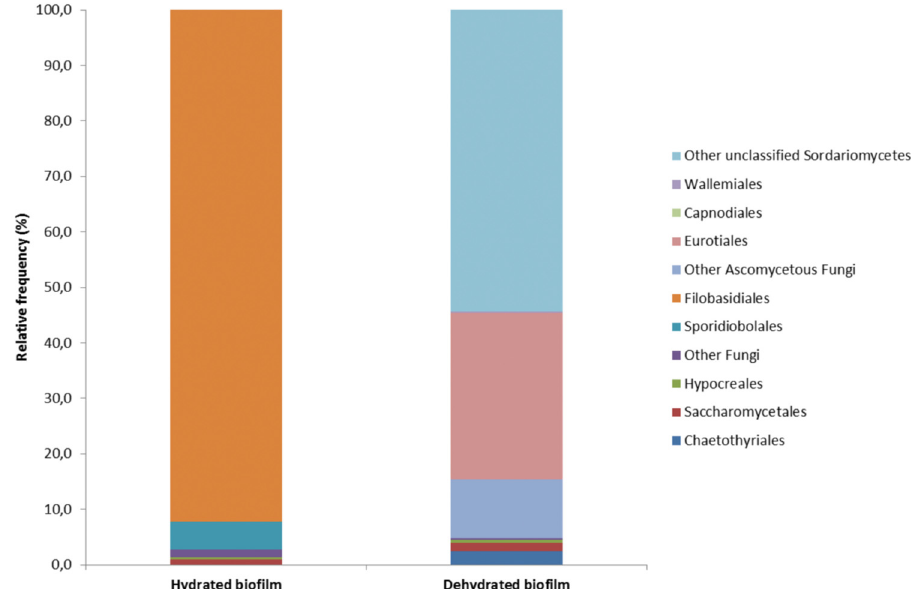
Fig 4. Orders of fungi identified from the hydrated and dehydrated biofilms. Left : The hydrated biofilm samples contained six different orders of fungi, as mainly Filobasidiales (especially genus Cryptococcus ; Basidiomycota ), Sporidiobolales (genus Rhodotorula ; Basidiomycota ) and Saccharomycetales (genus ’ s Saccharomyces , Hanseniaspora , Debaryomyces ; all belong to the Ascomycota ). Right : The dehydrated biofilms contained nine different orders of fungi, as mainly Hypocreales (including different moulds and genus Fusarium ; Ascomycota ), Eurotiales (genus ’ s Aspergillus , Penicillium , Talaromyces ; all belong to the Ascomycota ) and Xylariales (genus Hansfordia ; Ascomycota ). Both hydrated and dehydrated biofilms contained Chaerothyriales ( E . dermatitidis ) (0.07%, 1.77%, respectively) and Sordariomycetes ( F . dimerum ) (0.3%, 0.35%,